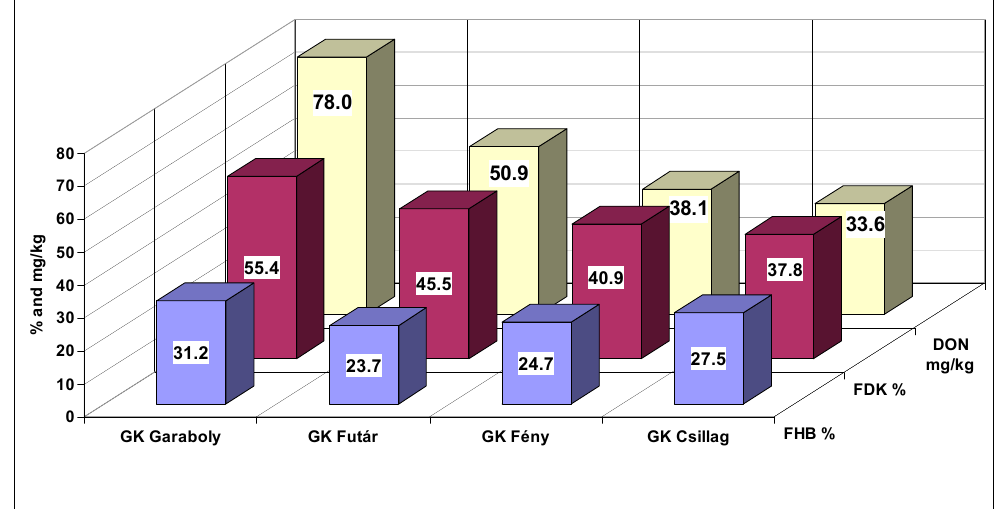
Figure 5. General performance of the cultivars across experiments and inocula for FHB (DI), FDK and DON contamination. LSD 5%: DI: 1.06, FDK: 1.97, DON: 4.68.